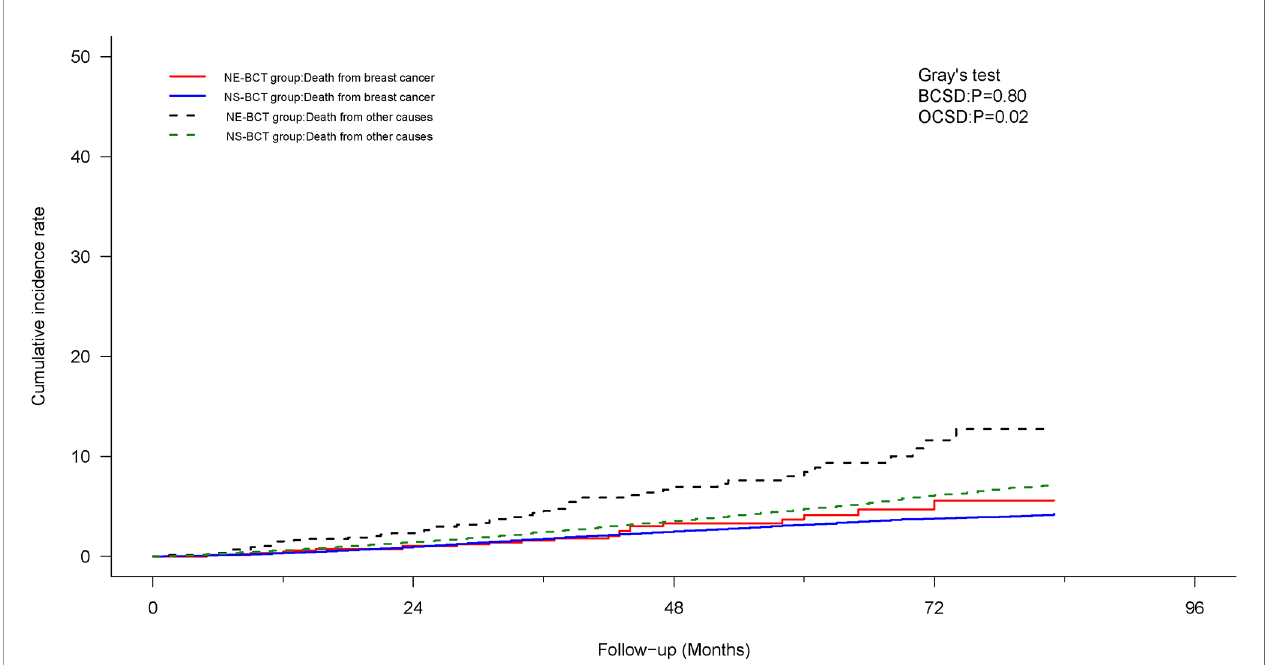
FIGURE 7 | Cumulative incidence of breast-cancer-speci fi c death (BCSD) and other causes of death (OCSD) in the NE-BCT and NS-BCT groups between 2010 and 2015.